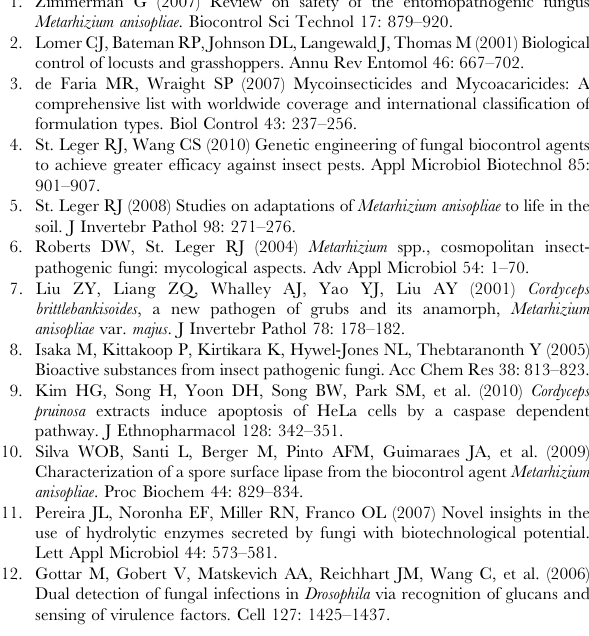
Table S9 Aspartyl proteases encoded in Metarhizium anisopliae and M. acridum genomes, arranged by MEROPS family. Table S10 Carbohydrate-degrading enzymes in Metarhizium species and other fungi, arranged by GH family. Table S11 Identification of genes coding for membrane transporters in Metarhizium anisopliae and M. acridum . Table S12 Cytochrome P450 (CYP) genes encoded in Metarhi- zium anisopliae and M. acridum genomes, arranged by CYP family. Table S13 The number of core genes involved in the biosynthesis of secondary metabolites in different fungi.